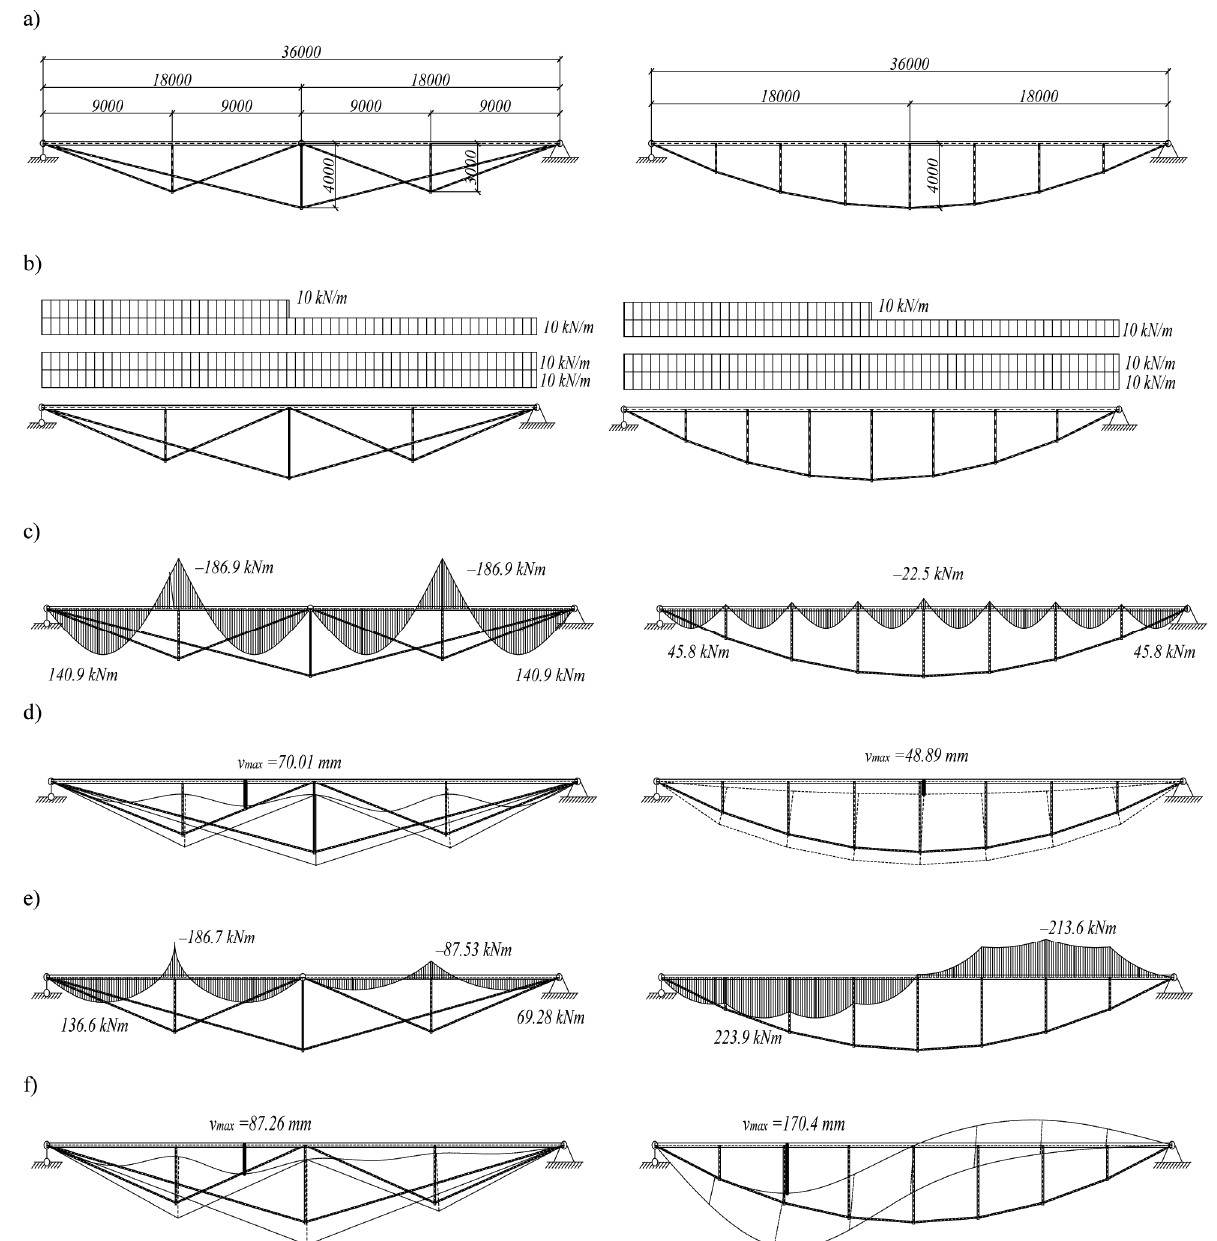
Fig. 3. The representation of the numerical analysis of alternative structural schemes for the under-deck cable-stayed bridge: a) geometrical parameters and structural schemes; b) application of symmetric and assymmetric loading; c) distribution of bending moments under symmetric loading; d) deflection shape of the structures under symmetric loading; e) distribution of bending moments under assymmetric loading; f) deflection shape of the structures under asymmetric